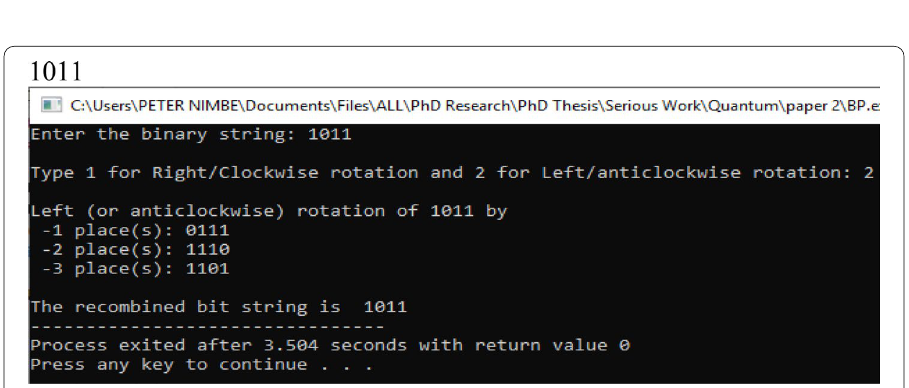
Fig. 13 Left or anticlockwise rotation of 101